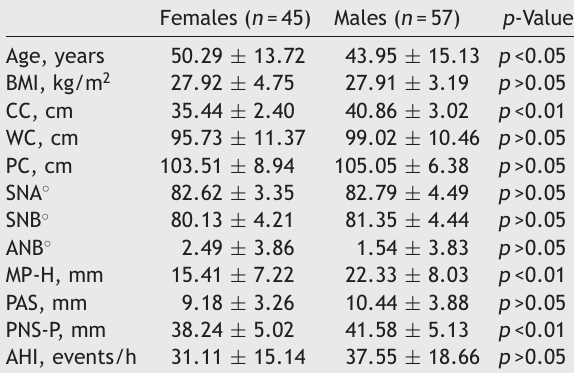
Comparison between males and females of age, anthropometric and cephalometric measurements, and AHI.